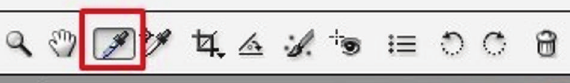
Figure 5: White Balance tool located at top left corner in ACR window. Note the red boxes in the figure. Follow them for an easy workflow.